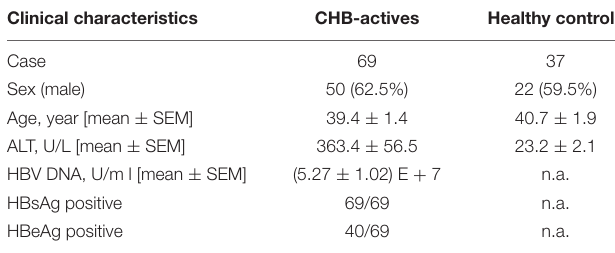
TABLE 1 | Clinical characteristics of enrolled